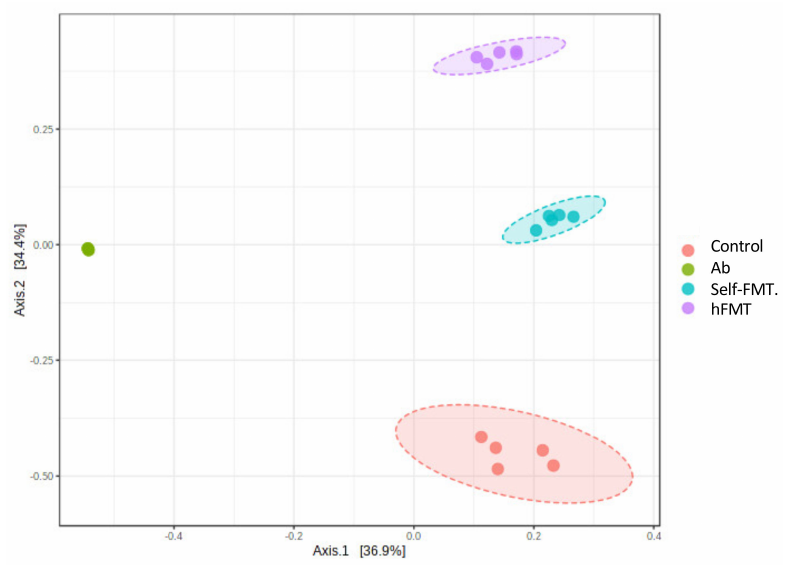
Figure 5. Differences in microbial global composition after the different treatments . A principal coordinate analysis (PCoA) of the Bray–Curtis dissimilarity indexes of samples based on OTUs is shown (PERMANOVA F–value = 53.642; R 2 = 0.90957; p < 0.001). Ab, antibiotic; hFMT, human fecal microbiota transplantation; self–FMT, self-fecal microbiota transplantation.